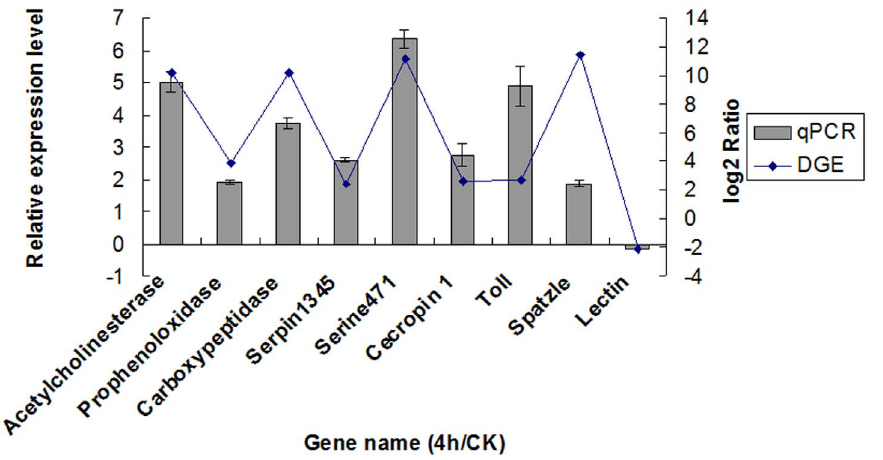
Figure 2. qRT-PCR validation of DGE result. Note: The left y-axis indicates the relative expression level by qRT-PCR, and the right y-axis indicates the log